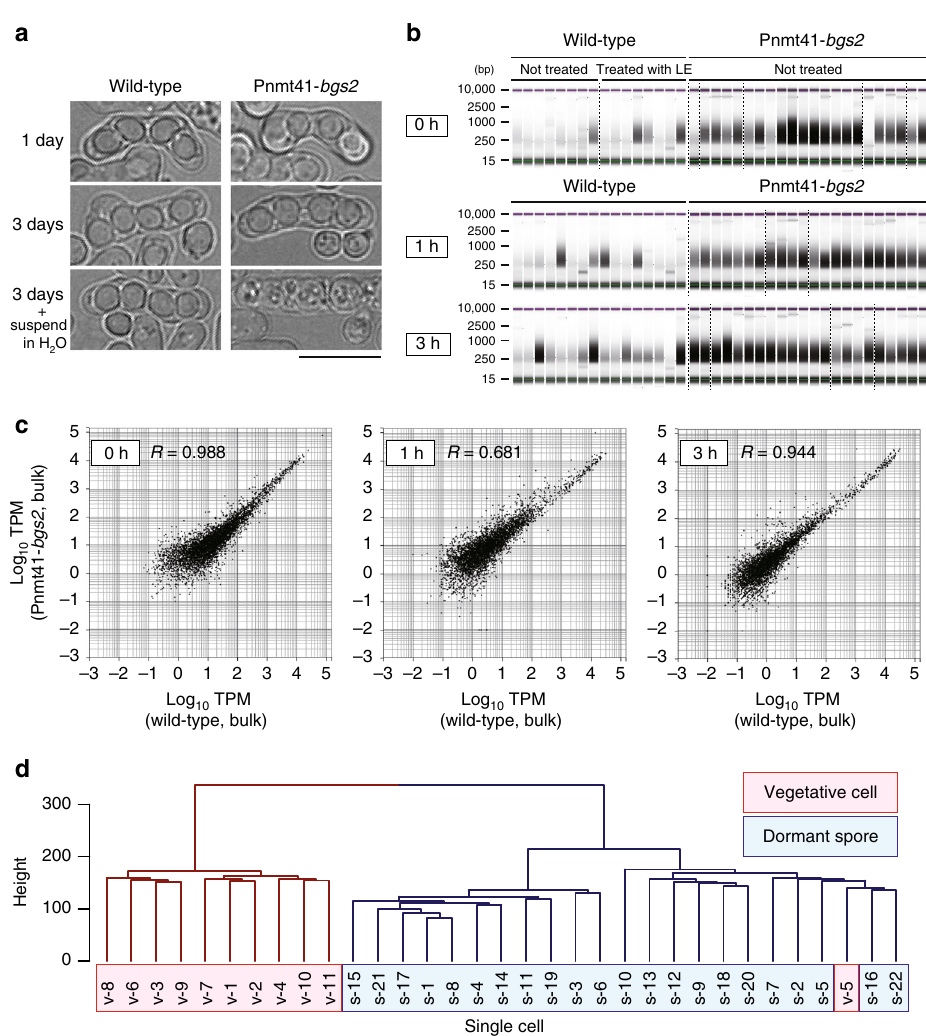
Fig. 2 scRNA-seq-based transcriptome assembly from a single spore cell. Strain Pnmt41- bgs2 was used to ef fi ciently prepare cDNAs from dormant or germinating spores. a Strain Pnmt41- bgs2 undergoes meiosis but produces fragile spores. WT ( bgs2 + ) spores could tolerate water, whereas Pnmt41- bgs2 spores burst. Representative cells of three independent experiments are displayed. Scale bar, 10 µ m. b , c Spores of the indicated genotypes were picked at 0, 1 and 3 h after nutrition feeding. b cDNAs were not produced in suf fi cient amounts from WT cells irrespective of whether they were treated with the lysing enzyme (left), whereas cDNA could be produced in suf fi cient amounts from Pnmt41- bgs2 spores even without lysing enzyme treatment (right). Uncropped original image is shown in Supplementary Fig. 8. c Global gene expression measured in strain Pnmt41- bgs2 did not differ signi fi cantly from that of the WT cells. d Transcription pro fi les of single vegetative cells (v-1 – v-11, red) and unfed dormant spores (s-1 – s-22, blue) were classi fi ed into distinct groups through an informatic operation. Relative height re fl ects the similarity between transcriptomes. Source data are provided as a Source Data fi